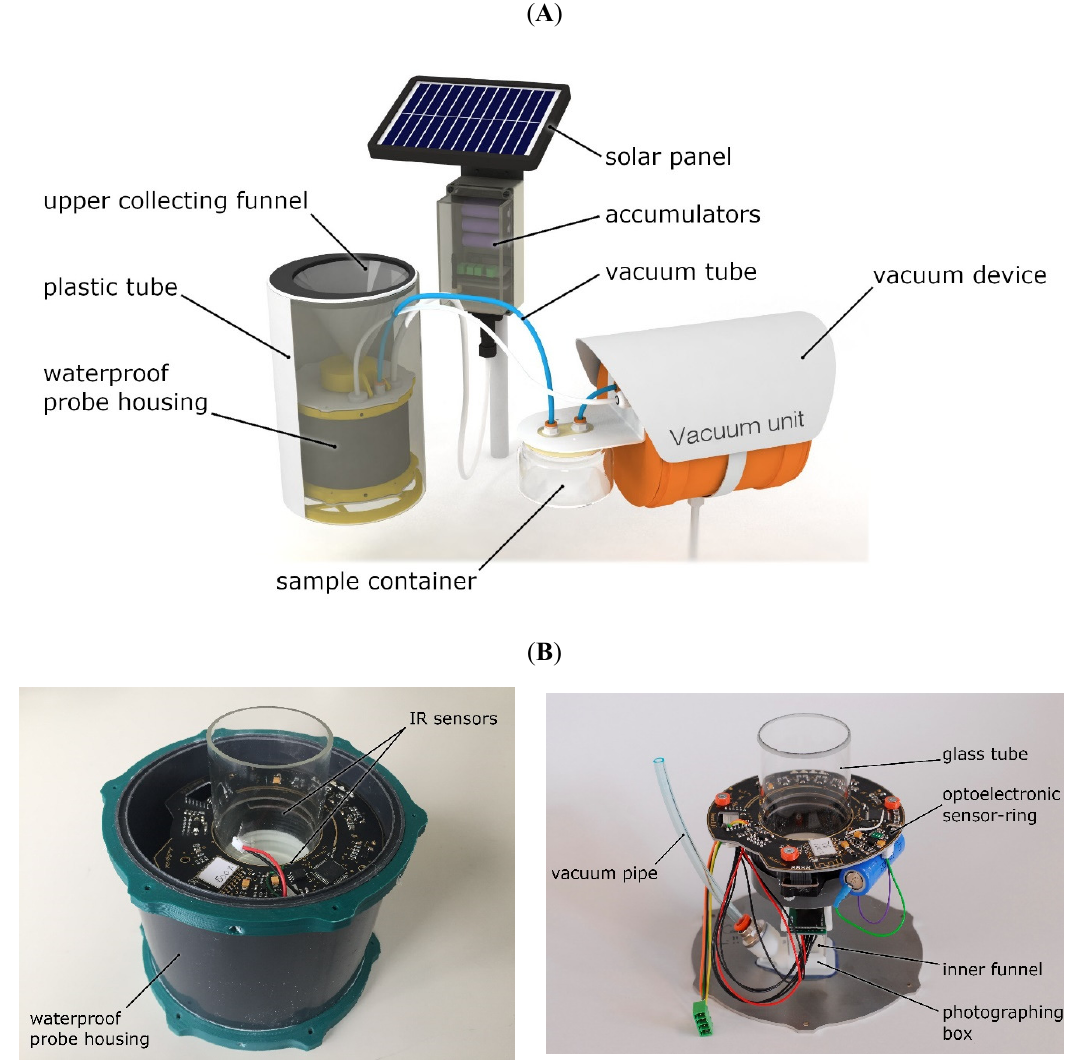
Figure 1. Construction of the new probe. ( A ) Construction of the camera-supported probe and the joint system (pneumatic unit and data logger with electric supply). ( B ) Photos of the probe, inside the protecting tube (left side) and components taken out from the protecting tube (right side).